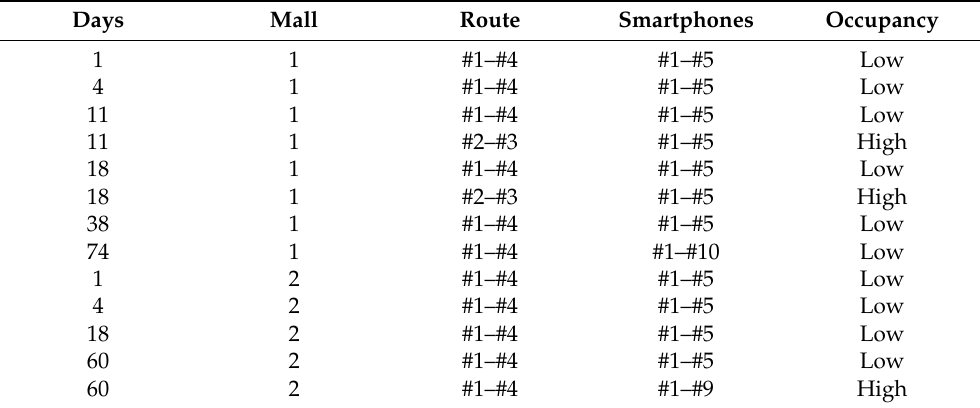
Table 3. Smartphones employed in each validation route, days elapsed after the calibration phase, and occupancy level.